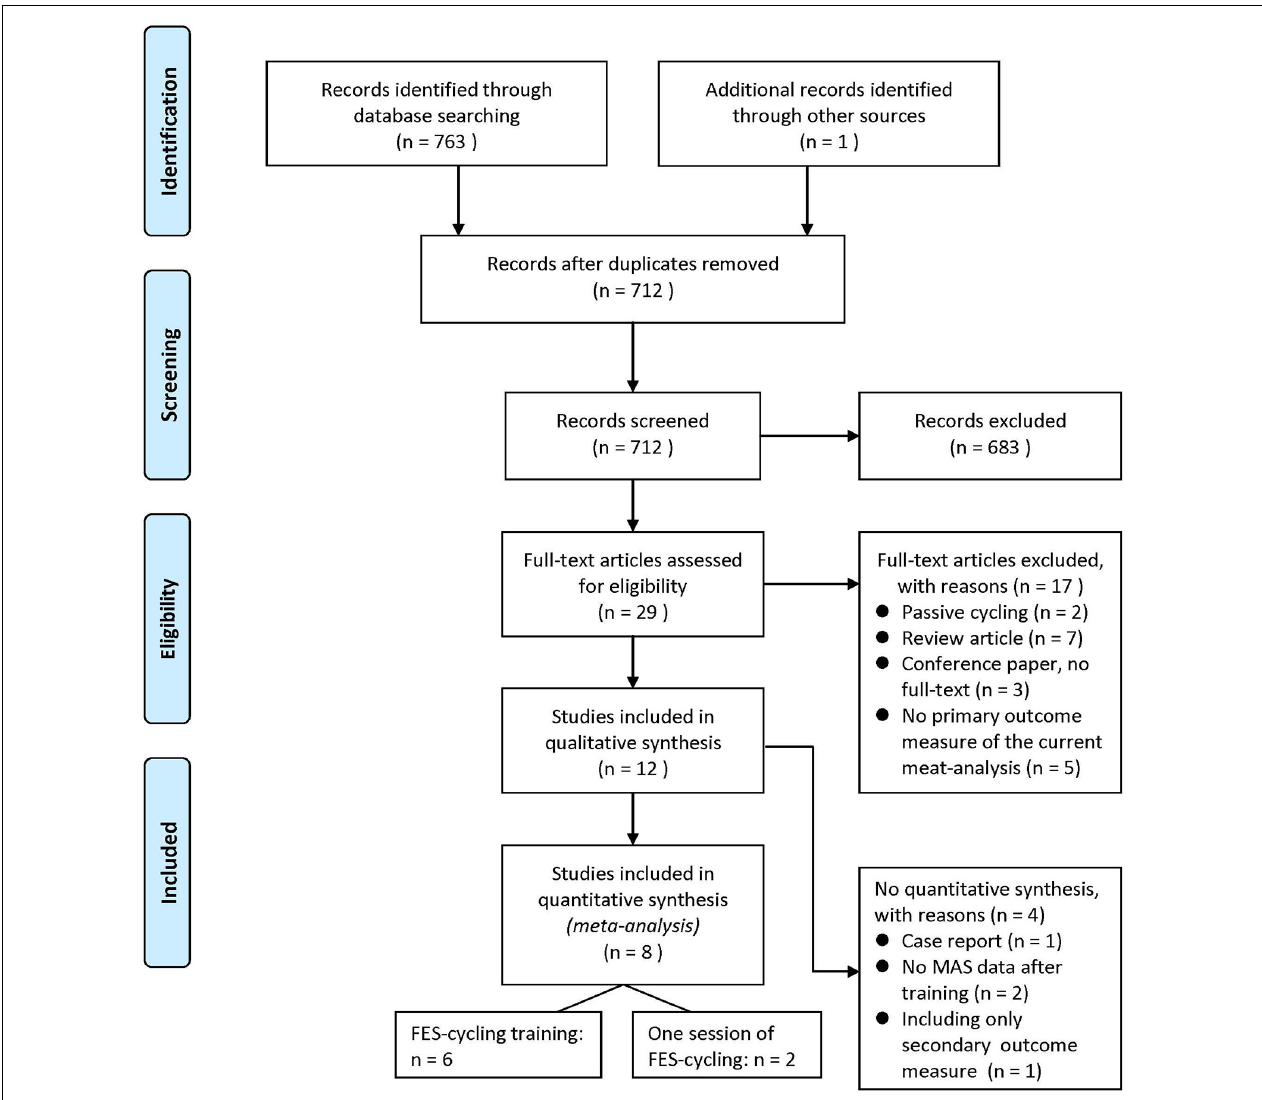
FIGURE 1 | Flow diagram of the study selection